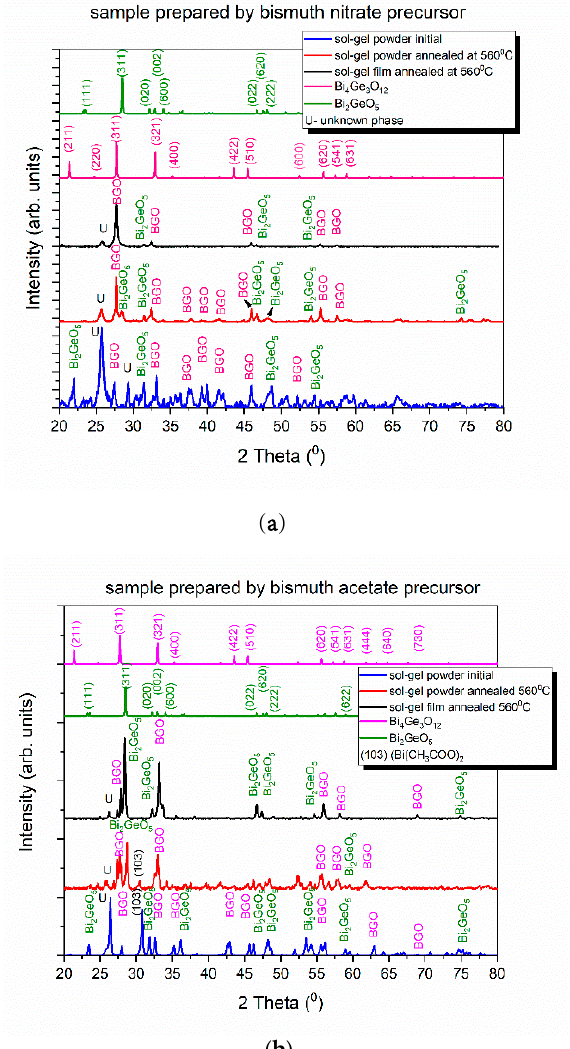
Figure 2. ( b ) XRD patterns for the sample prepared by bismuth acetate. Figure 2. ( a ) XRD patterns for the sample prepared by bismuth nitrate. ( b ) XRD patterns for the sample prepared by bismuth